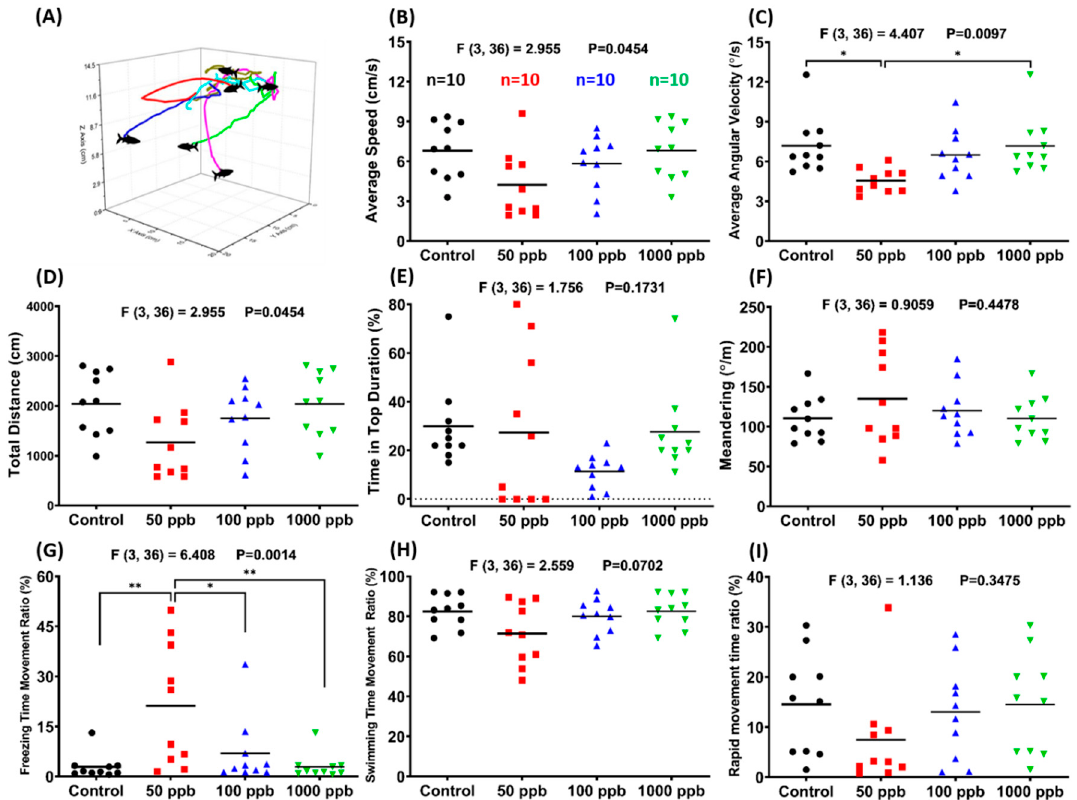
Figure 2. Comparison of three-dimensional (3D) behavior among seven-day PbCl 2 -exposed groups and a control group. ( A ) A schematic diagram showing the typical 3D locomotor paths of several individual fish, using our previously established method. Eight parameters were measured among treatments and a control group: ( B ) average speed, ( C ) average angular velocity, ( D ) total distance, ( E ) time in top duration, ( F ) meandering, ( G ) freezing time movement ratio, ( H ) swimming time movement ratio, and ( I ) rapid movement time ratio. Data are expressed in mean values evaluated by one-way ANOVA ( n = 10; * p ≤ 0.05, and ** p ≤ 0.01).